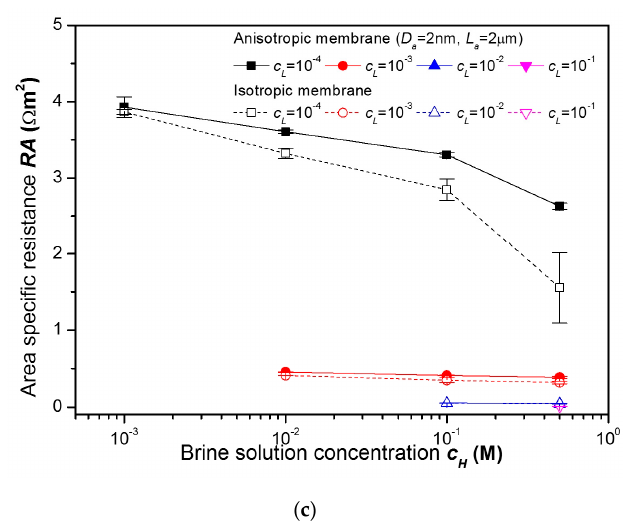
Figure 8. A comparison of: ( a ) power densities, ( b ) diffusion potentials, and ( c ) area specific resistances of the anisotropic nanoporous anodic aluminum oxide membrane ( D a = 2 nm, L a = 2 μ m) and the isotropic nanoporous anodic aluminum oxide membrane for various combinations of concentrations.